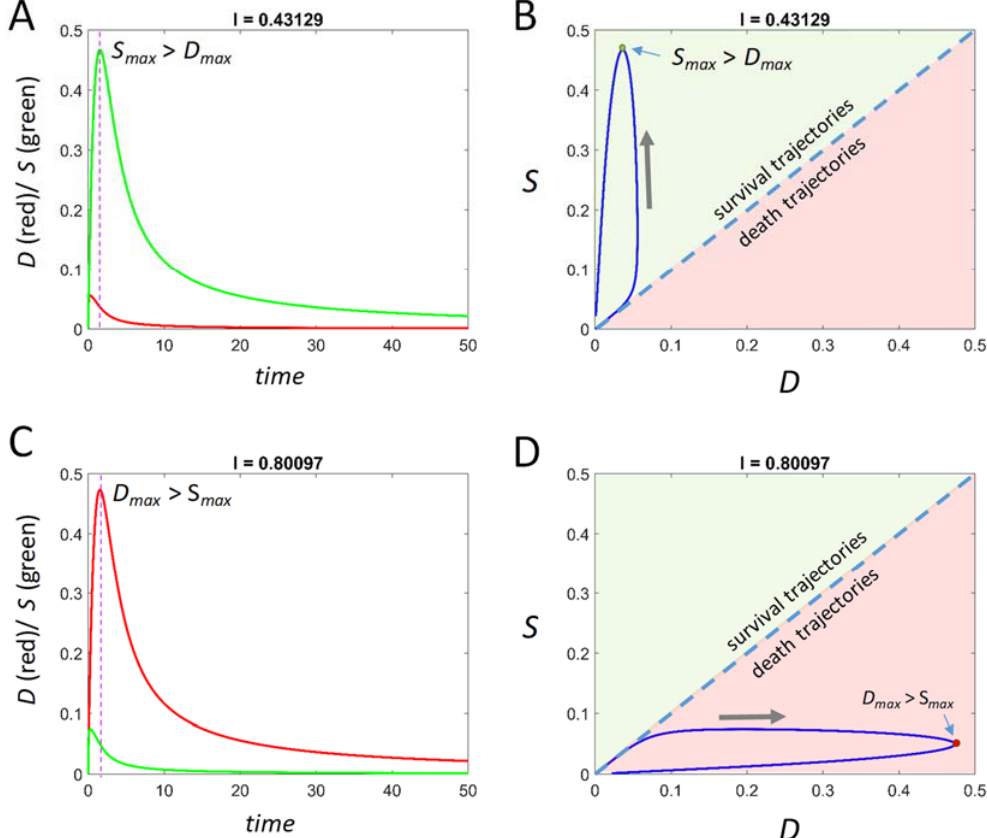
Figure 1. Example time courses calculated from Equation (5). ( A ) A pro-survival time course and ( B ) its corresponding trajectory on the phase plane. ( C ) A pro-death time course and ( D ) its corresponding trajectory on the phase plane. Purple dashed lines mark maximum values of time course in ( A , C ), and these are marked by green and red dots in ( B , D ), respectively. Blue dashed lines are the diagonal of the phase plane. Gray arrows indicate the flow direction of the trajectories. For this system, I X = 0.61.